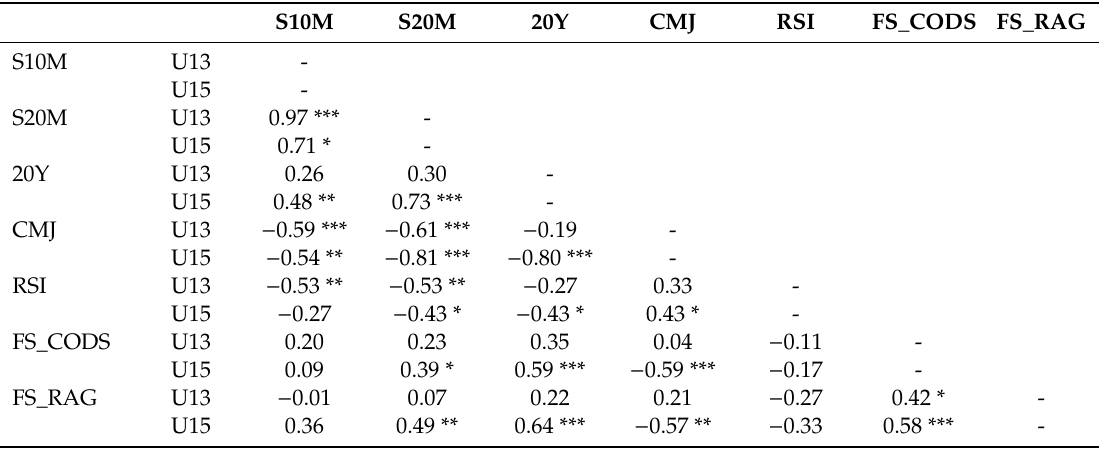
Table 4. Pearson’s product moment correlation coefficients between studied variables in each age category.